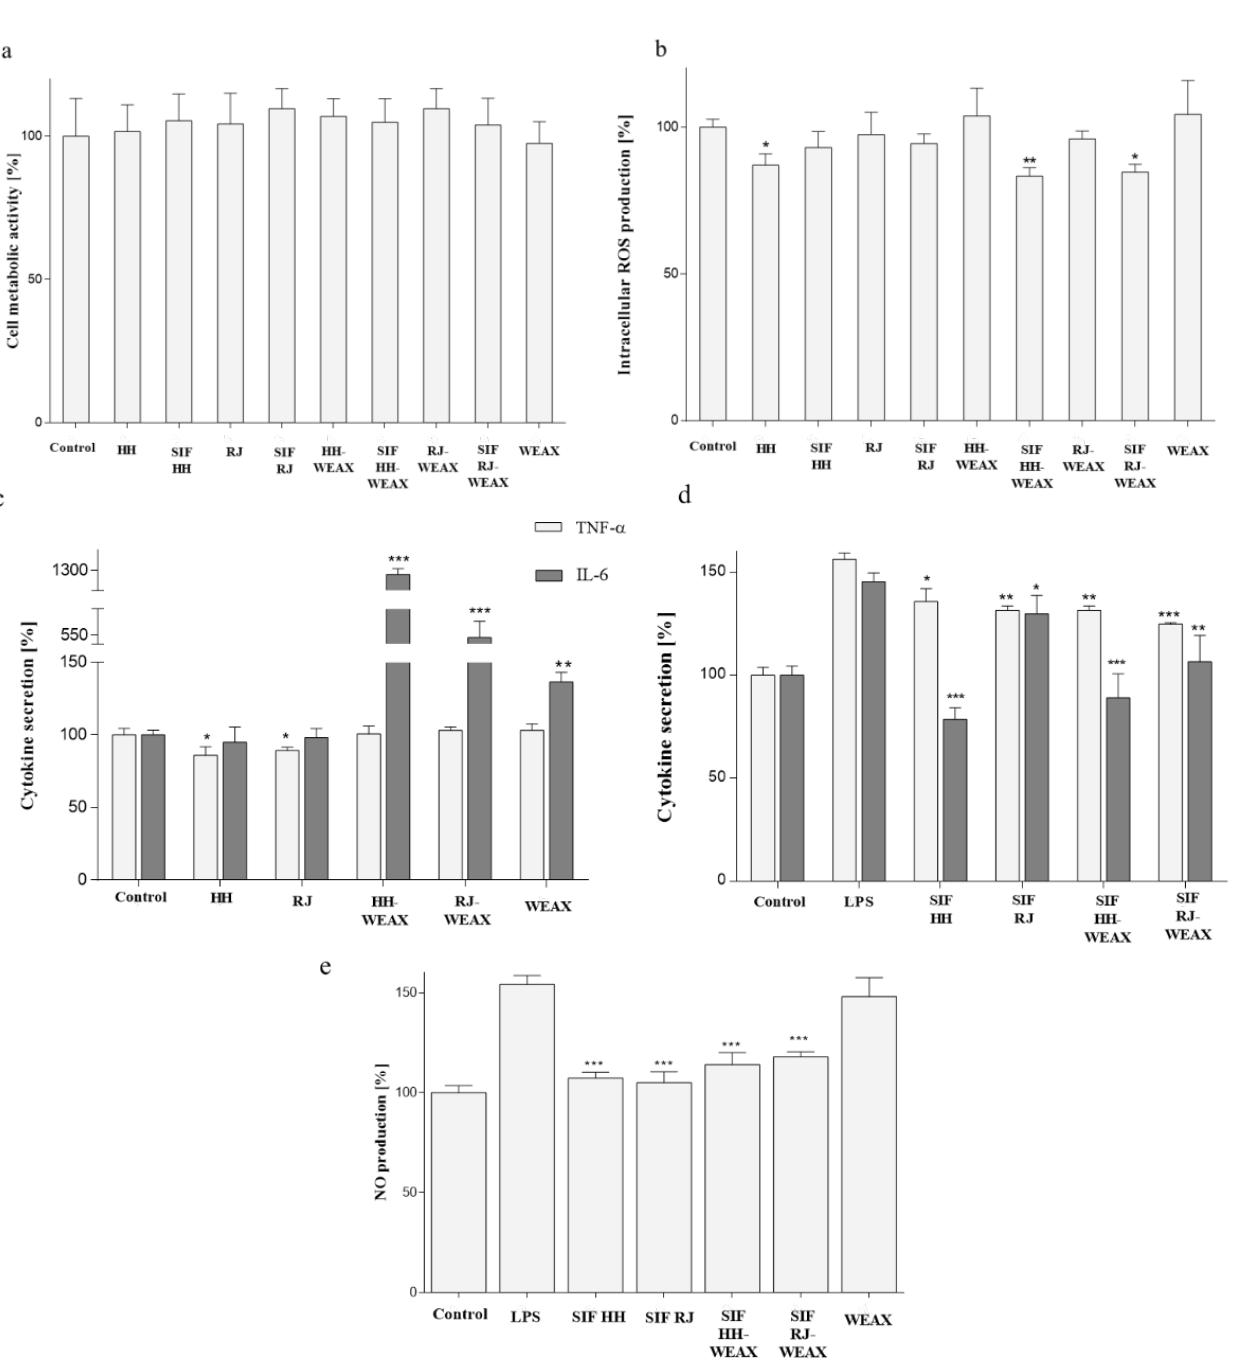
capsulated form on the concentration of intracellular free radicals was studied. The strongest effect on intracellular oxidative stress revealed HH-native with almost 15% de- crease comparing to the control cells (Figure 6b). Among the other encapsulated samples, there was observed no significant effect on ROS regulation in RAW 264.7. Interestingly, cells treatment with digested microcapsules SIF HH-WEAX and with SIF RJ-WEAX de- creased intracellular level of ROS to at least 15%. This clearly shows that both honey and royal jelly subjected to the encapsulation process with the use of WEAX carrier showed a lower effect on intracellular free radicals level than honey and royal jelly in their natural